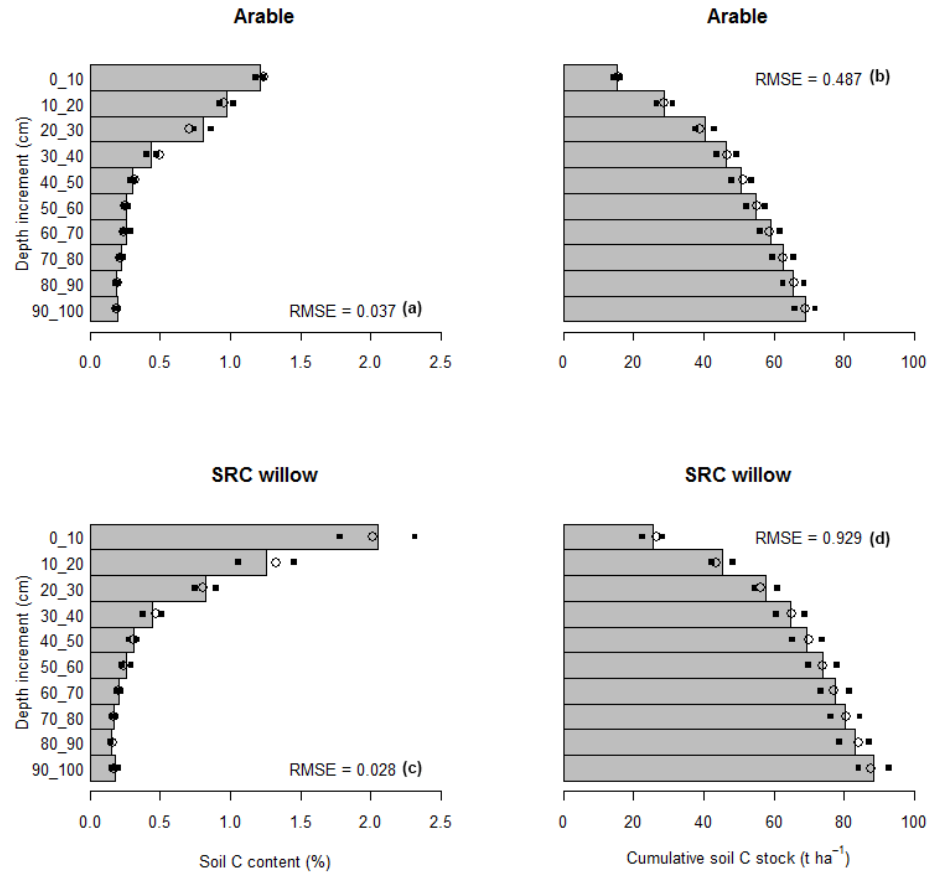
Figure 1. Soil carbon concentration (a, c) and cumulative carbon stock (b, d) of arable (a, b) and SRC willow (c, d) land uses in 10cm depth increments to 1m. Bars represent observed means, squares the standard error of observed means, and open circles the modelled means. Root mean square error (RMSE) calculated for the depth profile using means of observed and modelled data from the 10 depth